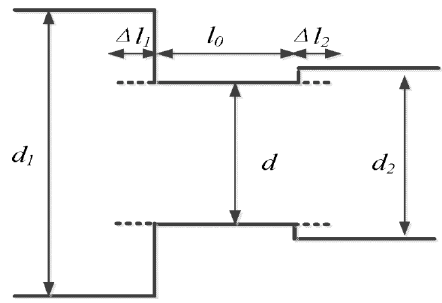
Figure 9. Tube end correction.